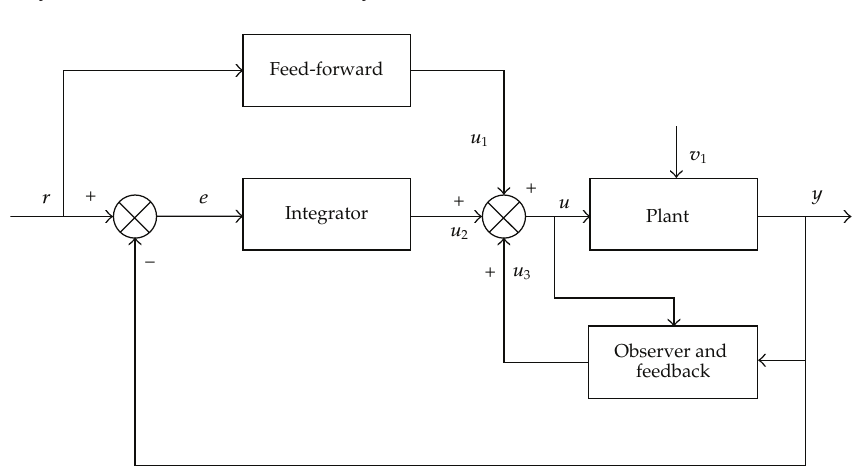
Figure 1: Tracking control scheme for continues-time